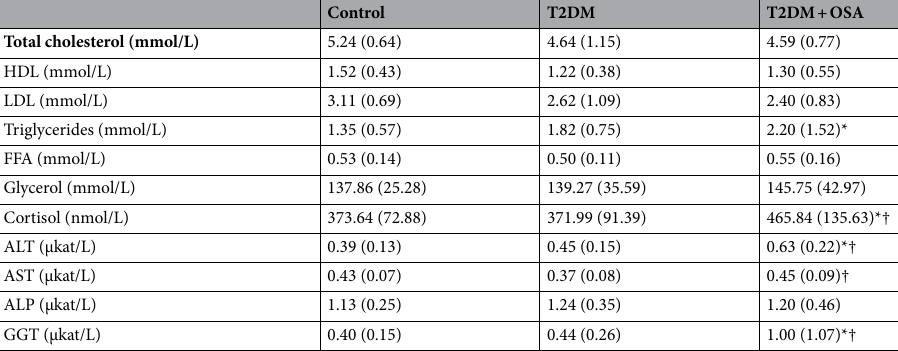
Table 2. Biochemical characteristics of recruited subjects. Data are mean (SD). HDL, high density lipoprotein; LDL, low density lipoprotein; FFA, free fatty acids; ALT, alanine transaminase; AST, aspartate transaminase; ALP, alkaline phosphatase; GGT, gamma-glutamyl transferase. *Significant difference ( p < 0.05) compared with control group. † Significant difference ( p < 0.05) compared with T2DM group.